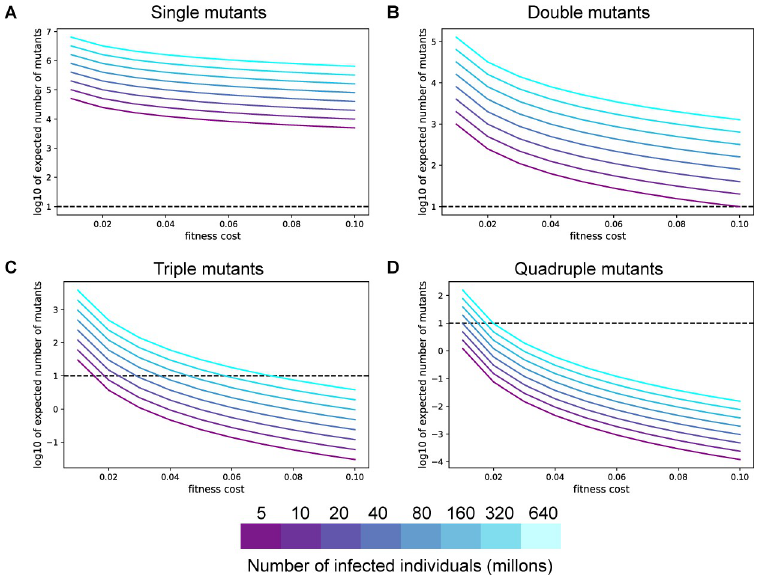
Fig 3. SARS-CoV-2 mutants with one or two mildly deleterious mutations are expected to exist at high numbers. A-D. The expected number of individuals infected with a specific single ( A ), double ( B ), triple ( C ), or quadruple ( D ) SARS-CoV-2 mutant viruses at different values of the fitness cost. For all panels, the colors denote the total number of individuals with active SARS-CoV-2 infection globally. The horizontal dashed line is the drift boundary calculated at a fitness benefit of 0.1 for the mutation